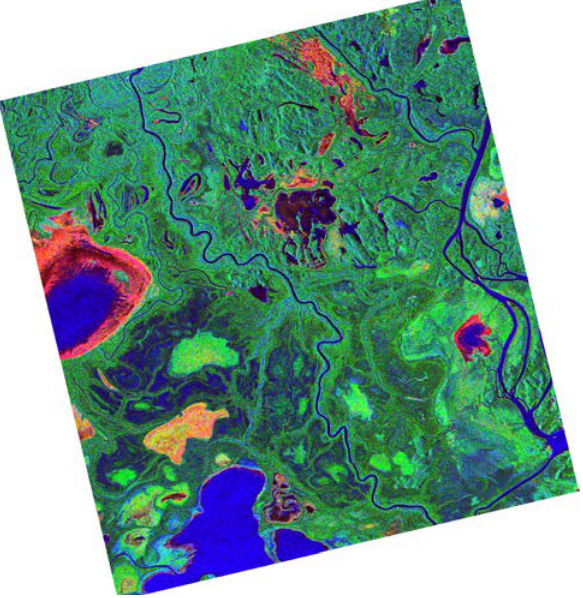
Figure 6. Example Freeman-Durden decomposition product of the PAD for 2014. The double bounce scattering is in red which highlights wetlands due to flooded